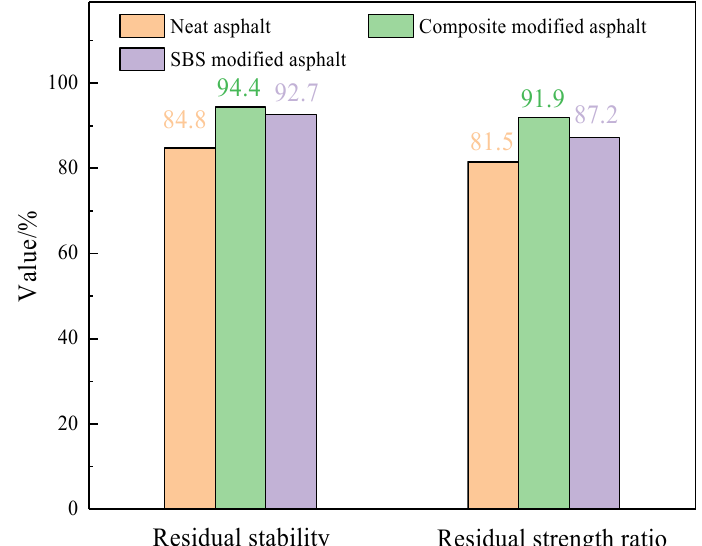
Figure 11. Test results of water stability.